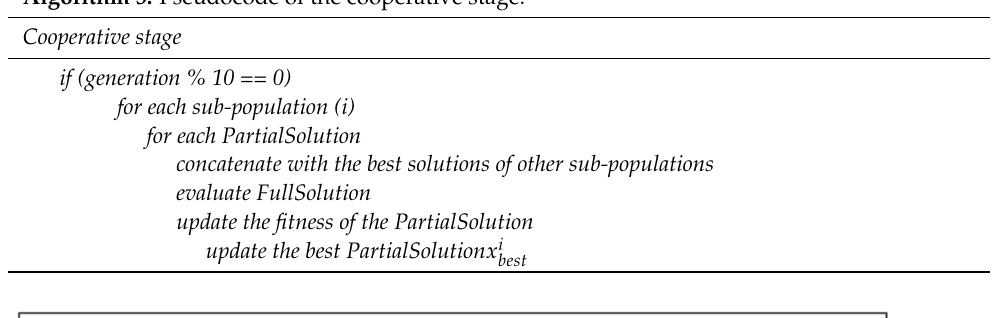
Algorithm 5. Pseudocode of the cooperative stage.